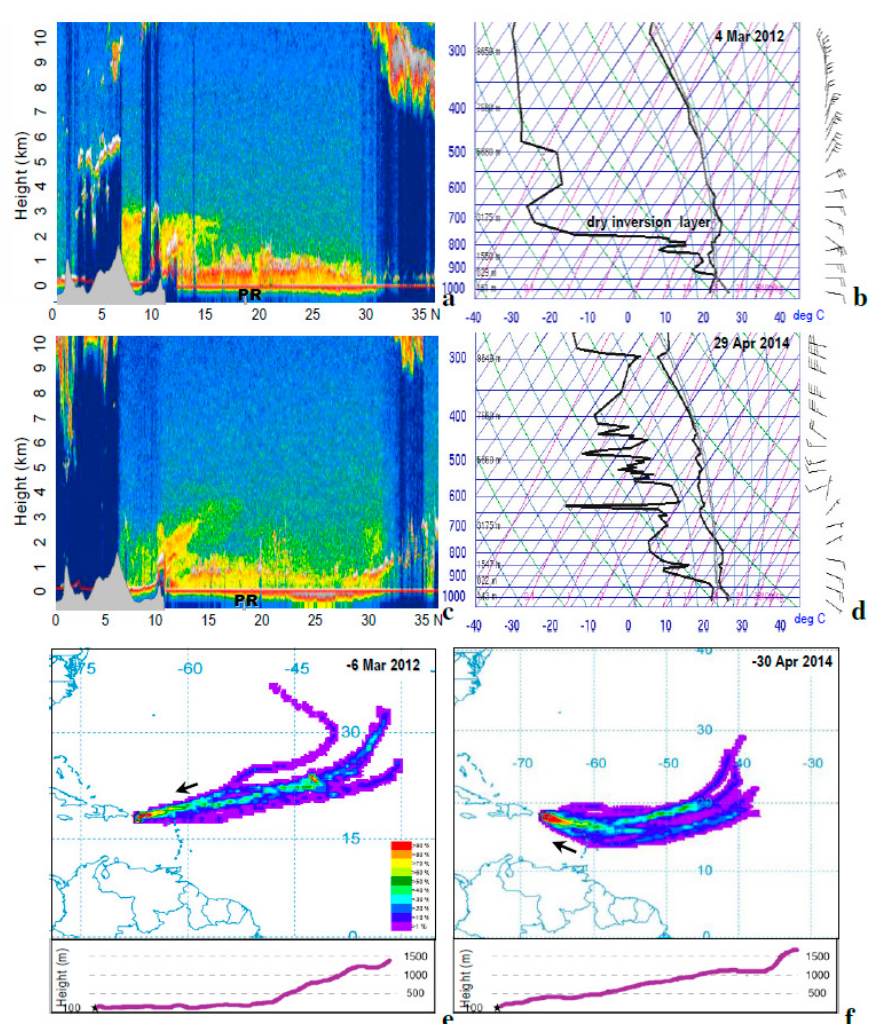
Figure 8. CALIPSO S-N section of aerosol density on ( a , c ) 06UTC 4 March 2012 and 29 April, and ( b , d ) corresponding radiosonde profiles from San Juan. Five-day HYSPLIT back-trajectory probability plots ending on: ( e , f ) 6 March 2012 and 30 April 2014, with vertical axis in lower panel.